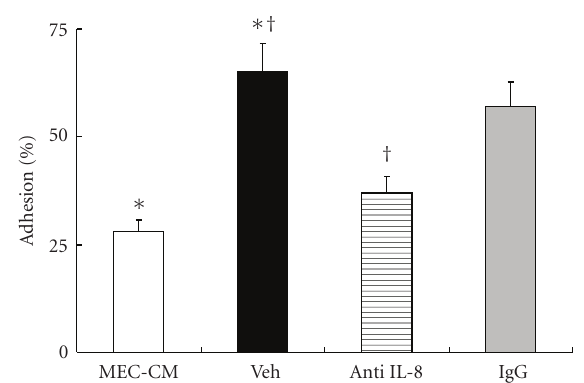
Figure 7: The radiosorbent assay for adherence between neu- trophils and HUVECs. The percentage of adherence between radio- labeled neutrophils and endothelial cells was significantly increased in the 10 SP/MEC-CM (Veh group) compared with the MEC-CM. The percentage of adherence between radiolabeled neutrophils and endothelial cells in the 10 SP/MEC-CM was significantly less than that in Veh group. ∗ , † P < .